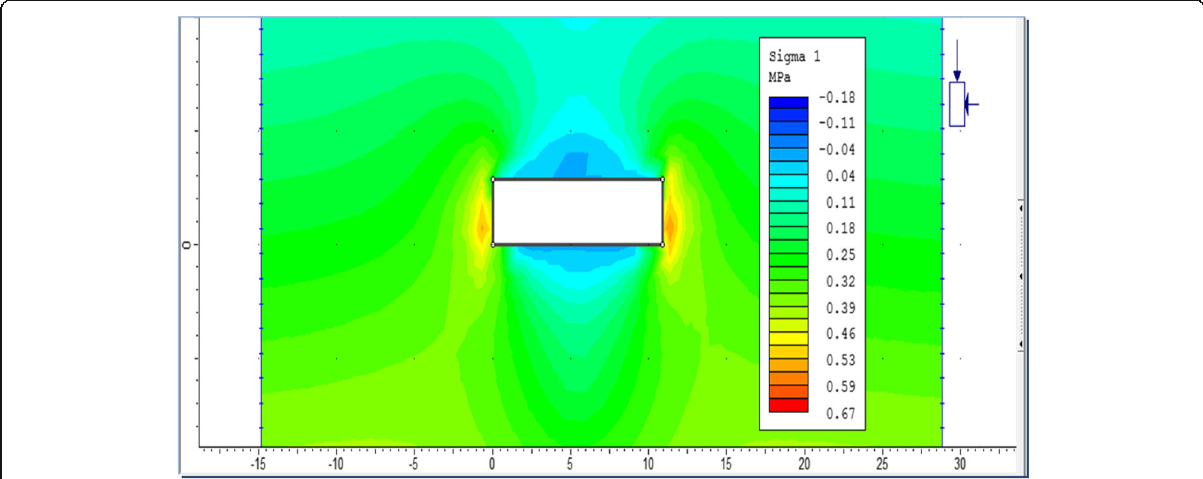
Fig. 17 Effective vertical stresses, the ceiling and sidewalls of northern Chamber. Examine 2D